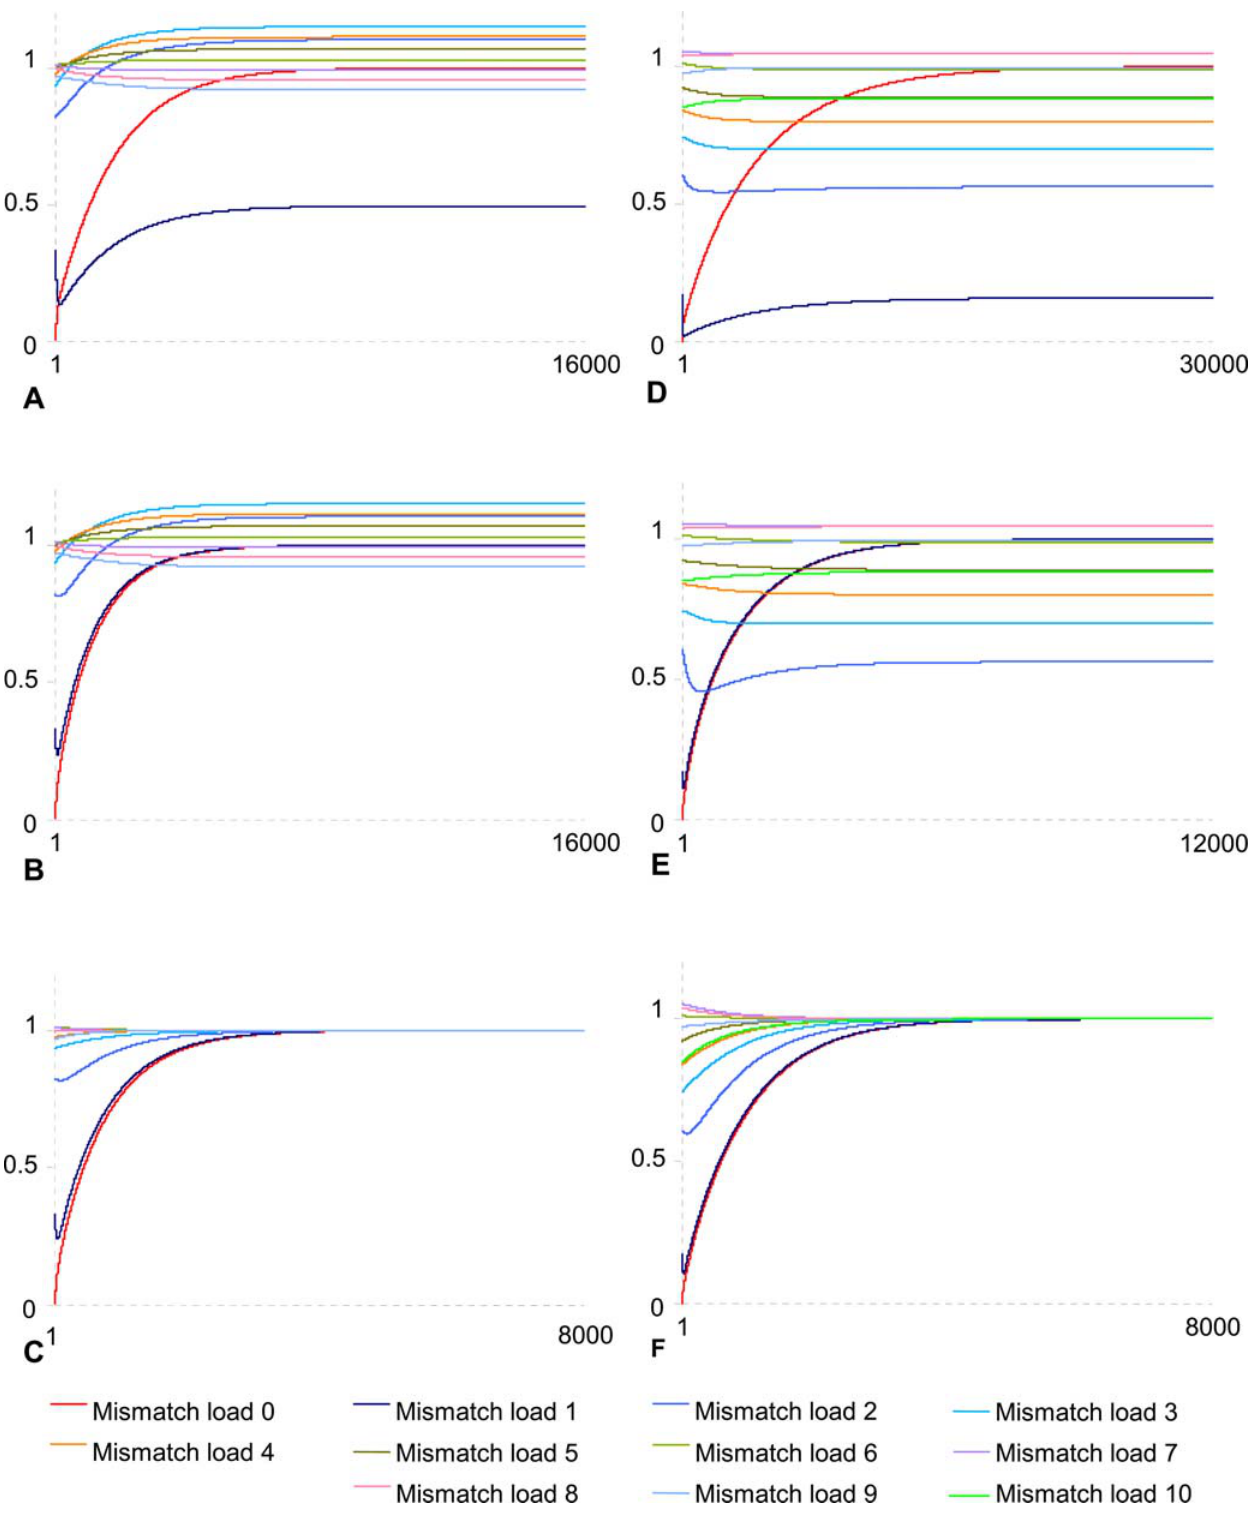
Figure 2. Computer simulation of the accumulation of H.influenzaeand N.gonorrhoeaeDUESs. X-axis: Cycle ( i.e. , generation). Y-axis: Ratio of the number of sequences after each simulation cycle to the observed ( i.e. , real) number. A and D : Genomes of H. influenzae ( A ) and N. gonorrhoeae ( D ) evolving with 104.4 and 477.5 uptake bias towards their respective DUES. B and E : The same genomes evolving with an additional 1.02 and 5.284 uptake bias towards the singly-mismatched DUESs. C and F : The same genomes evolving with the uptake bias combinations (156.4; 2.016; 0.352; 0.295; 0.340; 0.395; 0.449; 0.505; 0.563; 0.623) and (499.2; 5.567; 0.857; 0.493; 0.306; 0.175; 0.056; 0; 0; 0.051; 0.184) towards sequences with 0 to 9 and 0 to 10 mismatches to the respective DUES—semicolons separate uptake biases for different mismatch loads.